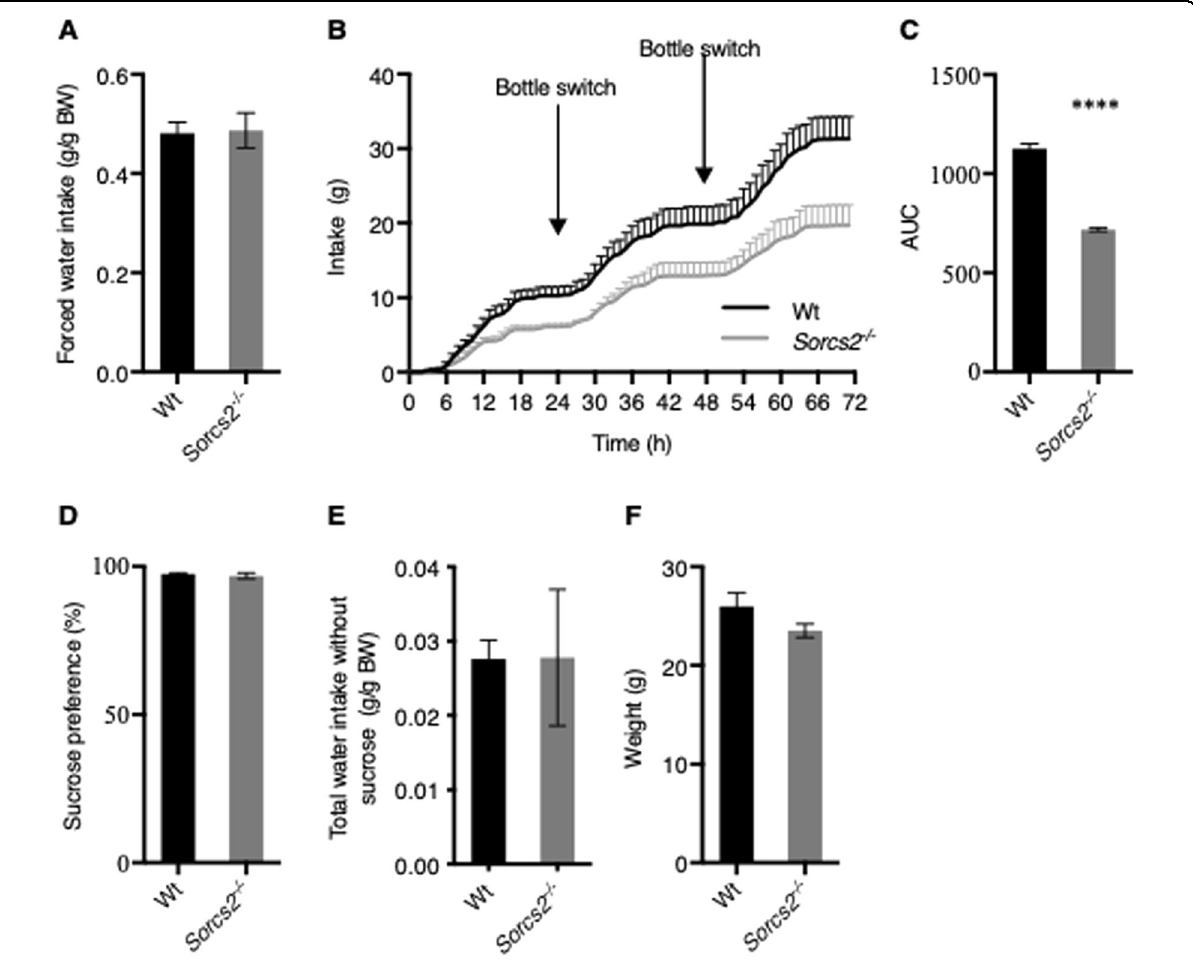
Fig. 2 Sorcs2 − / − mice have lower sucrose intake. A Identical water intake in Wt and Sorcs2 − / − mice during a period of 48 h when water was the only drinking source (Student ’ s unpaired t -test, p > 0.9). B , C Cumulative intake of 4% sucrose solution of Wt and Sorcs2 − / − mice in a two-bottle test paradigm. Reduced consumption of sucrose-containing solution in Sorcs2 − / − mice compared to Wt mice displayed as AUC ( p < 0.0001, Student ’ s unpaired t -test). D Sucrose preference (Student ’ s un-paired t -test p > 0.5). E Water intake during the three days of experiment ( p > 0.15, Student ’ s unpaired t -test). F The weights of Wt and Sorcs2 − / − mice were not signi fi cantly different ( p > 0.16, Student ’ s unpaired t -test). 4 mice of each genotype were tested. **** p <